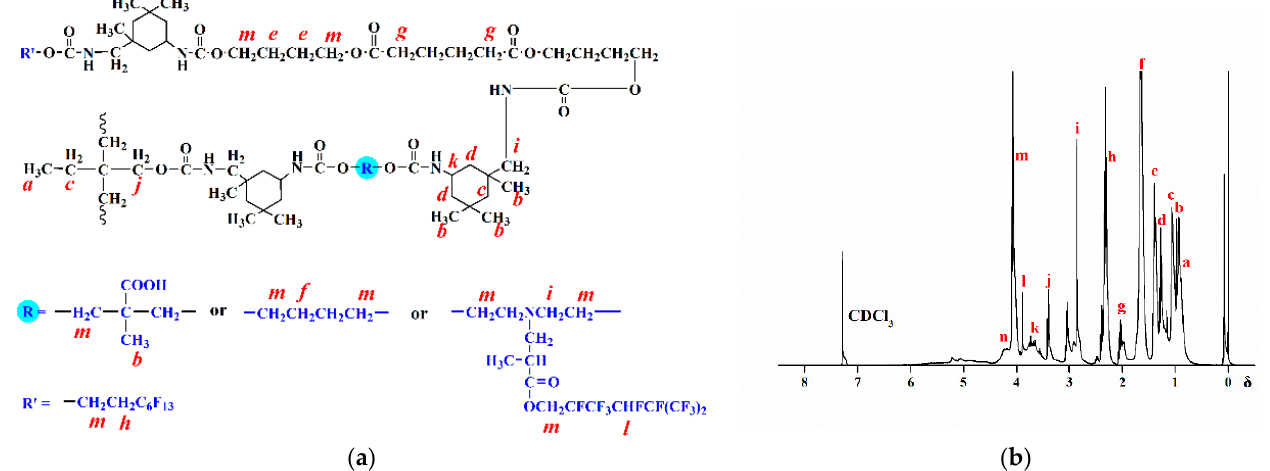
Figure 3. 1 H NMR spectrum of TPFPU-4. ( a ) labels of hydrogen protons , ( b ) 1 H NMR spectrum.